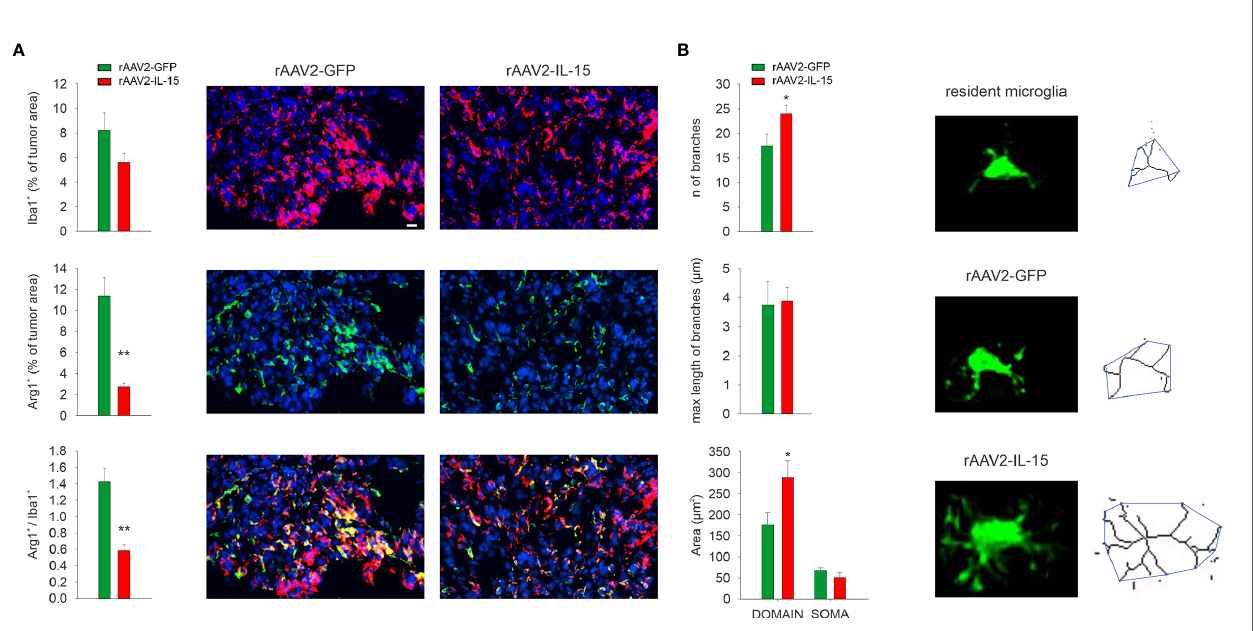
FIGURE 4 | Intranasal delivery of rAAV2-IL-15-infected microglion-shaped M/M F phenotype. (A) Quanti fi cation of Iba1+, Arg1+, and Iba1+/Arg1+ cells in the tumor area upon i.n. delivery of rAAV2-GFP or rAAV2-IL-15 microglia. Bars represent the mean (± s.e.m.) area expressed as percentage of total tumor areas. Representative immuno fl uorescence images are shown on the right (N = 4 mice per condition; **p < 0.01, *p < 0.05 Student ’ s t test). Scale bar: 20 µm. (B) Quanti fi cation of area of the branching, soma, and scanning domain of Iba+ cells measured by ImageJ in slices from GL261-bearing mice treated, as indicated (six slices, four mice per condition, **p = 0.0034, Student ’ s t-test). Below: representative images of maximum intensity projections of a confocal z-stack imaging on peritumoral area of Iba+ cells, converted to binary images and then skeletonized by the Analyze Skeleton plugin in ImageJ (green